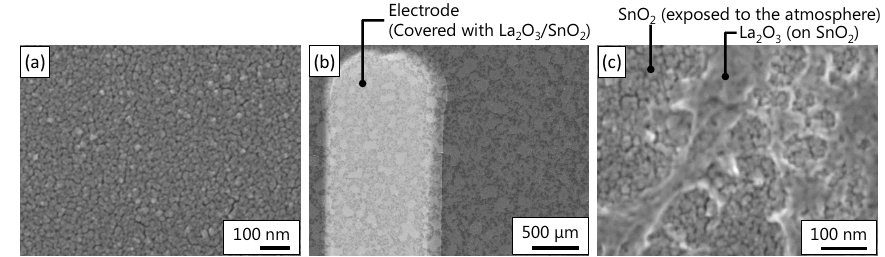
Figure 3. Scanning electron microscopy images of the material: ( a ) SnO 2 surface; ( b ) La 2 O 3 /SnO 2 surface; and ( c ) the magnified image of ( b